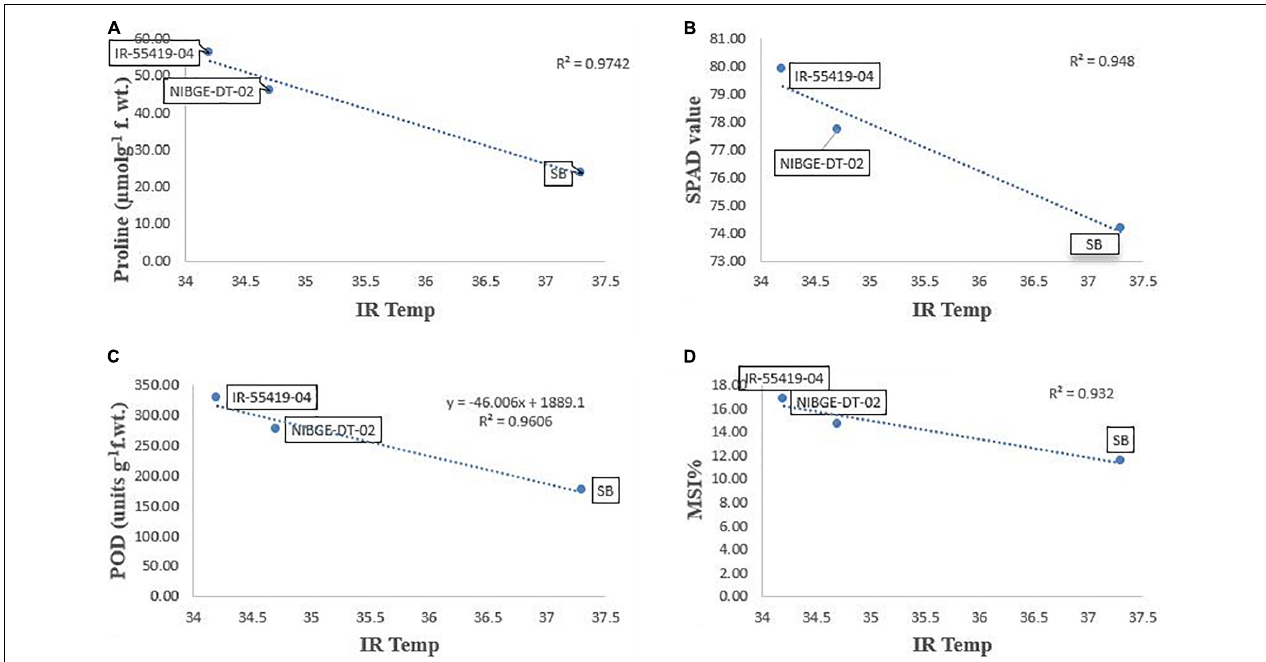
FIGURE 8 | Correlation analysis of Infrared (IR) temperature with different traits for three tested genotypes under early-stage stress conditions. (A) Relationship between IR-temperature and proline content. (B) Relationship between IR-temperature and SPAD values. (C) Relationship between IR-temperature and POD enzyme. (D) Relationship between IR-temperature and MSI%. Relationships were studied by correlation analysis using SPSS software. Means are an average of four biological replicates at p = 0.05 according to the LSD.